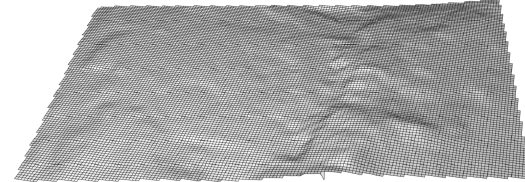
Figure 10. The terrain of the UNSW campus.